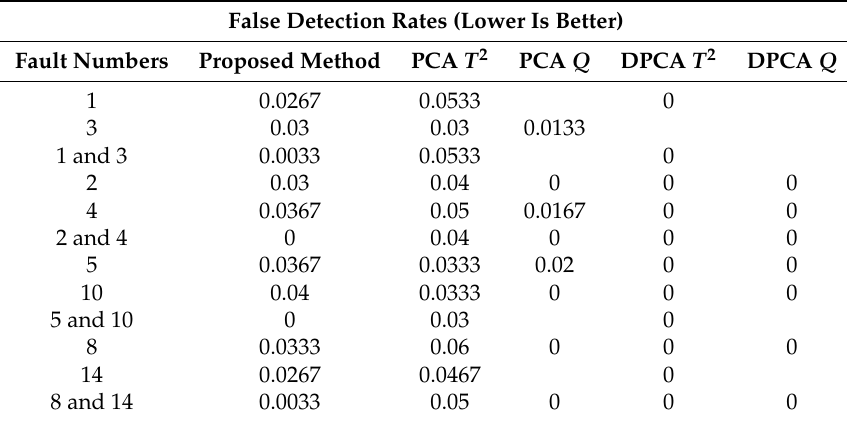
Table 4. False detection rates for the Tennessee Eastman